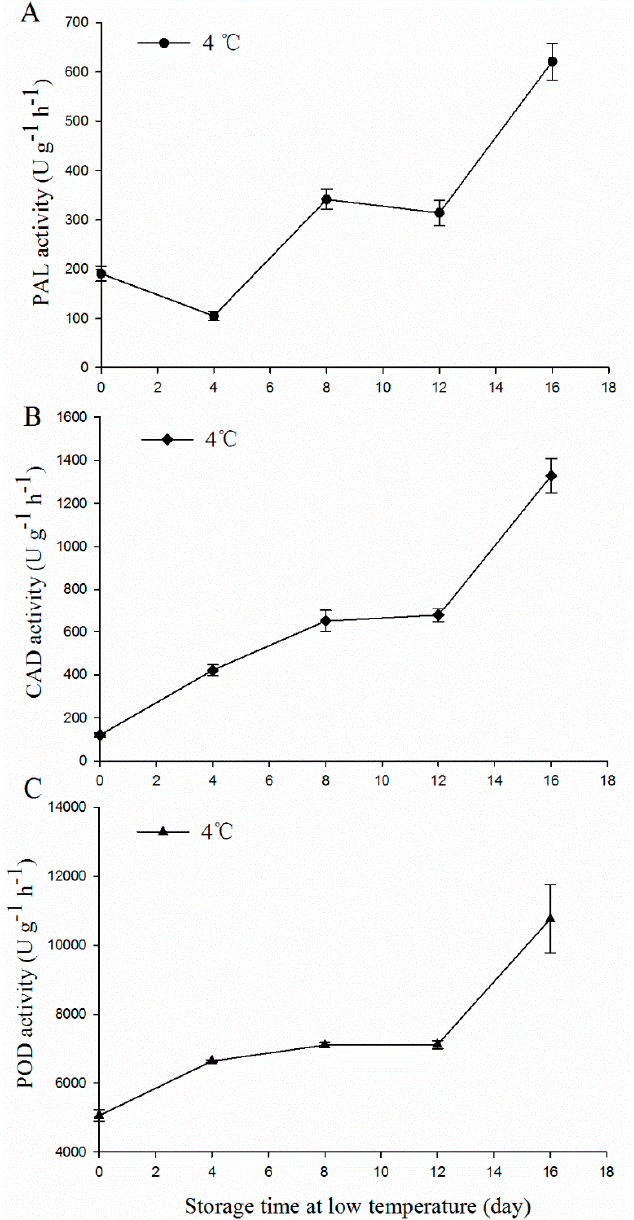
Figure 2. Activities of ( A ) phenylalanine ammonia lyase (PAL), ( B ) cinnamyl alcohol dehydrogenase (CAD), and( C ) peroxidase (POD) in MBSes during cold storage. Data were average values ± standard error (SE) ( n = 3).